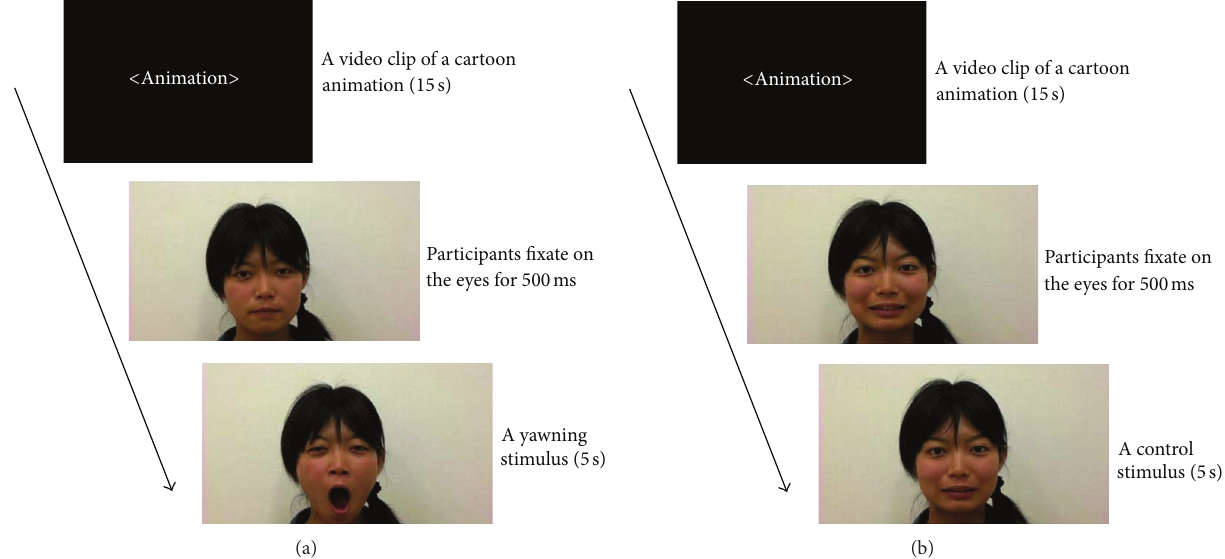
Figure 1: An example of the stimulus sequence of (a) yawn block and (b) control block. This sequence was repeated 24 times, and a video clip of a cartoon animation was presented at the end in each block.